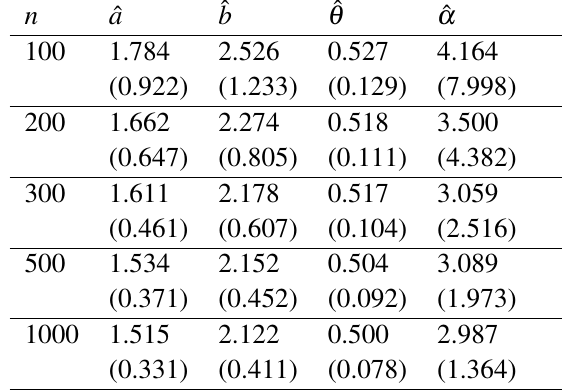
Table 1. Empirical means and the RMSEs of the EWP distribution for a = 1 . 5 , b = 2 , θ = 0 . 5 and α = 3 .